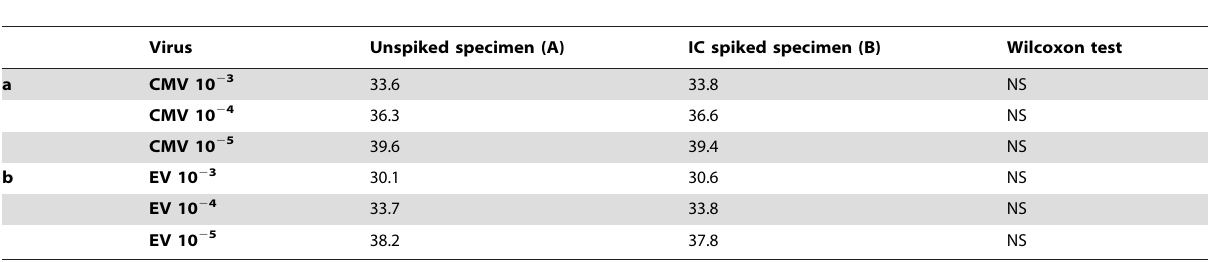
Table 2. Influence of spiking on the performance of viral nucleic acid purification.